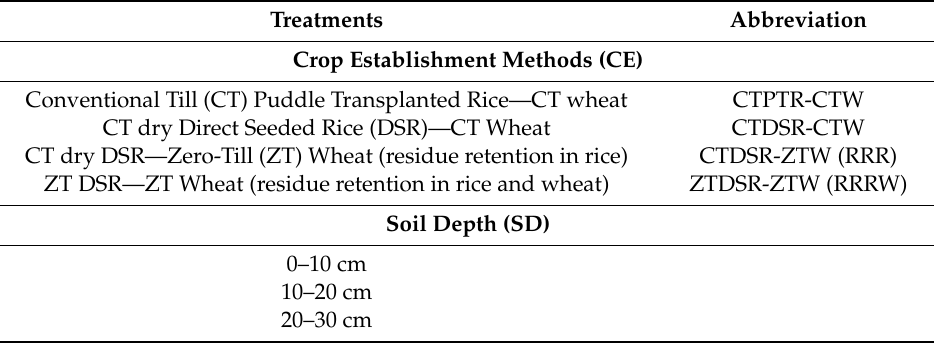
Table 2. Details of